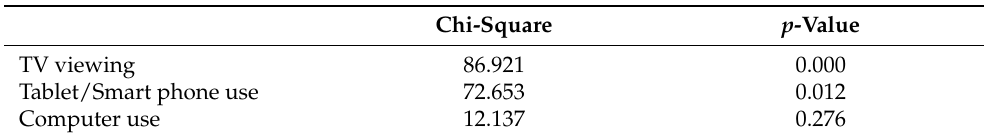
Table 5. Association between foods consumed in front of technological devices and weight status of children. Chi-Square p -Value TV viewing 86.921 0.000